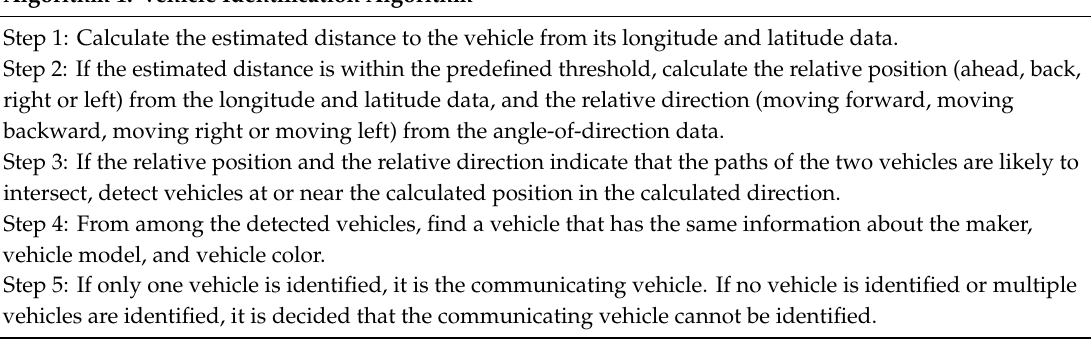
Algorithm 1. Vehicle Identification Algorithm